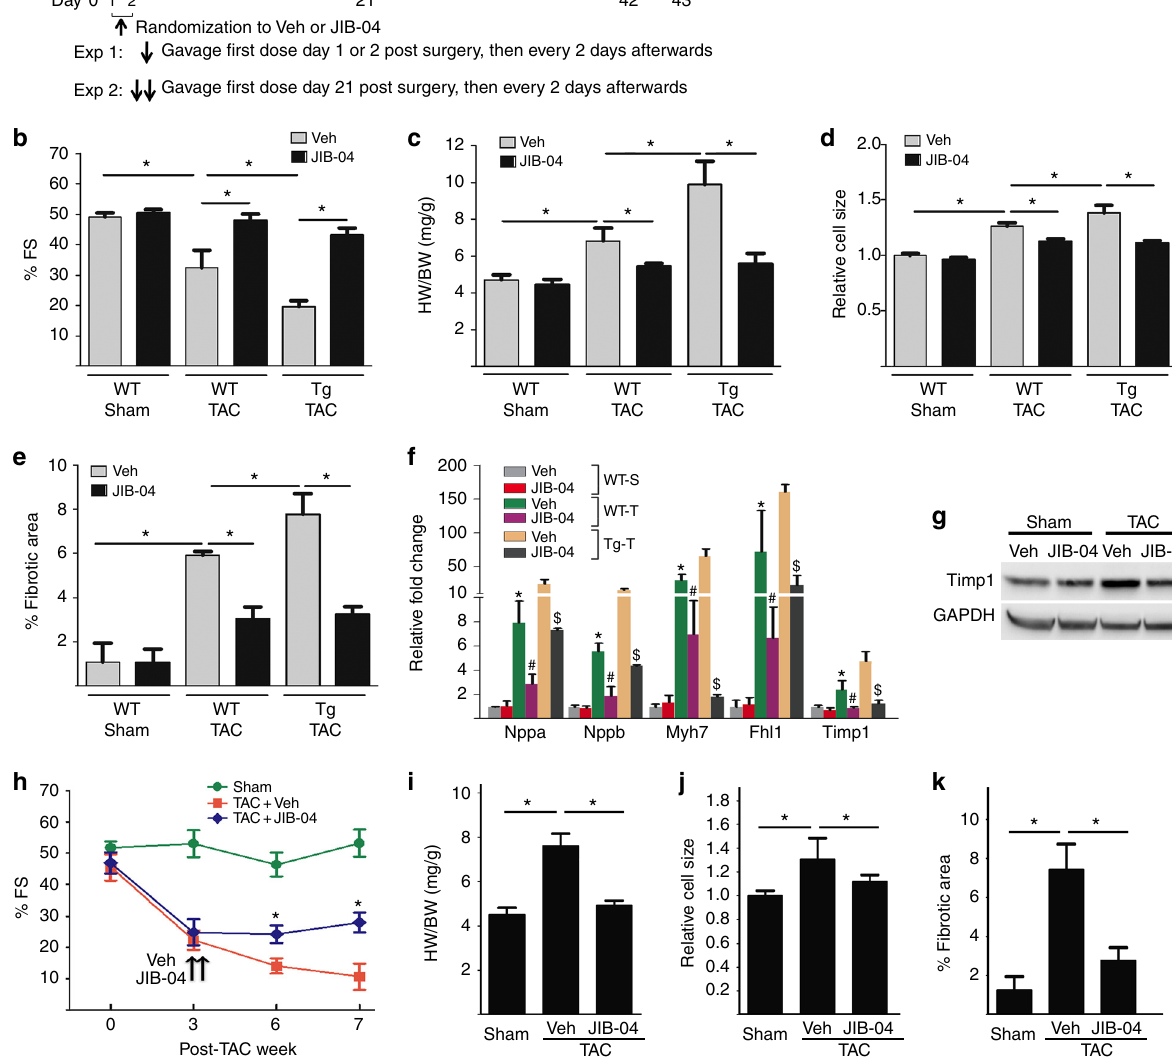
Fig. 6 JIB-04 blocks TAC-induced hypertrophic remodeling and fi brosis. a Experimental protocol of JIB-04 and control vehicle (Veh) treatment of WT and Kdm3a -Tg mice. JIB-04/Veh were given to mice at either day 1 or 2 (exp 1) or 21 (exp 2) post-TAC. b %FS, c HW/BW ratio, d relative cell size, e percentage of fi brotic area, and f relative fold change of fetal genes and Timp1 of WT sham, WT TAC and Kdm3a -Tg TAC mouse heart at the end of experiment 1. n = 5-6 ± SEM, *, # , $ , p < 0.05 (ANOVA). *, WT TAC vs WT Sham. # , JIB-04 WT TAC vs Veh WT-TAC. $ , JIB-04 Tg TAC vs Veh TG TAC. g Western blot of TIMP1 in vehicle or JIB-04 treated WT mouse hearts at post-sham/TAC week 6 in experiment 1. h %FS over treatment period, i HW/ BW, j relative cell size, and k % fi brotic area at end of experiment 2 of Sham and TAC Kdm3a -Tg mouse hearts treated with vehicle or JIB-04. n = 5 ± SEM, * p < 0.05 (ANOVA)